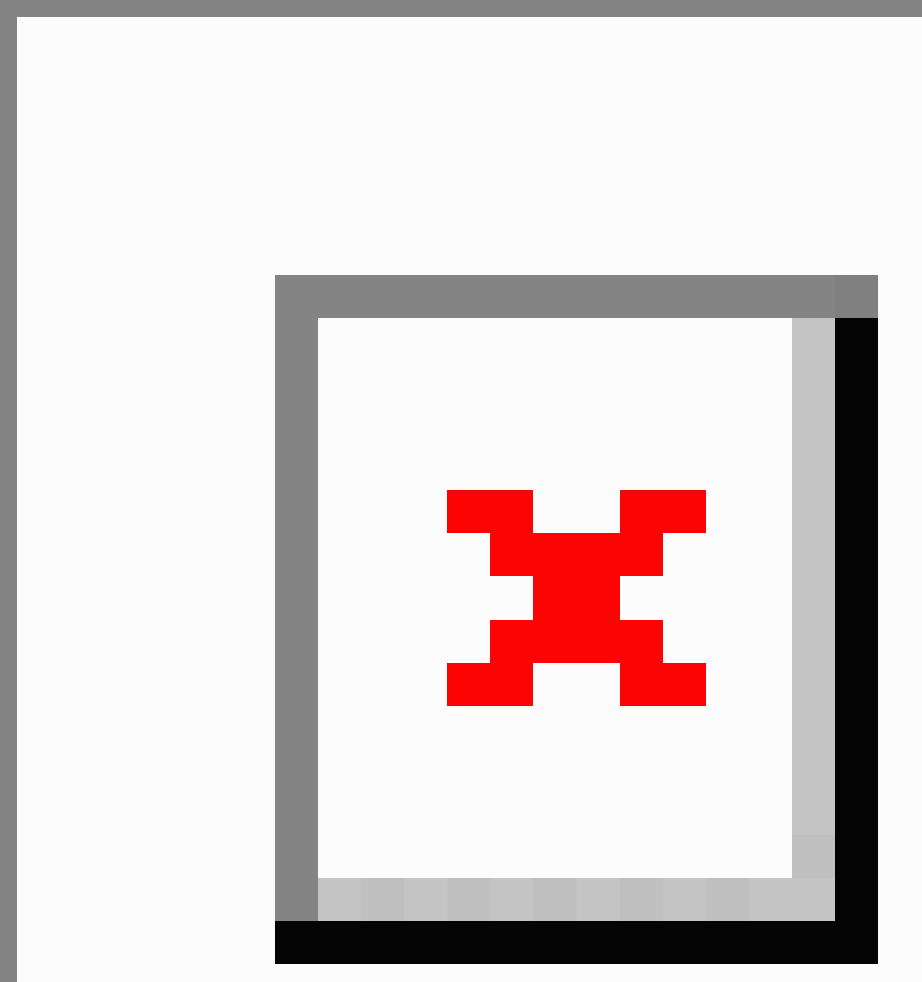
Figure 1. Participation in the Get Healthy, Stay Healthy (GHSH)